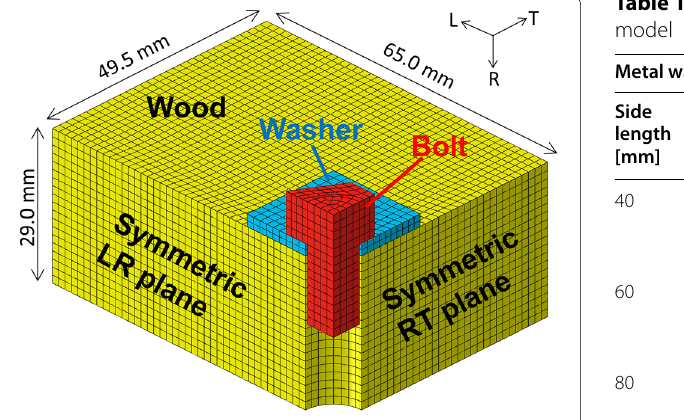
Fig. 2 Finite-element model of metal washer with a thickness of 2.3 mm and a side length of 40 mm (L: longitudinal, T: tangential, R: radial)